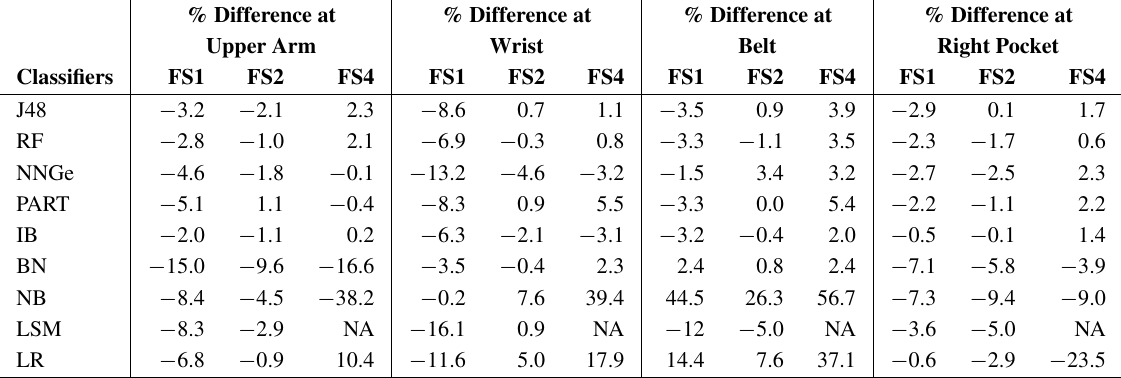
Table A.3. Performance difference (gyroscope—accelerometer) for the walking activity in Scenario